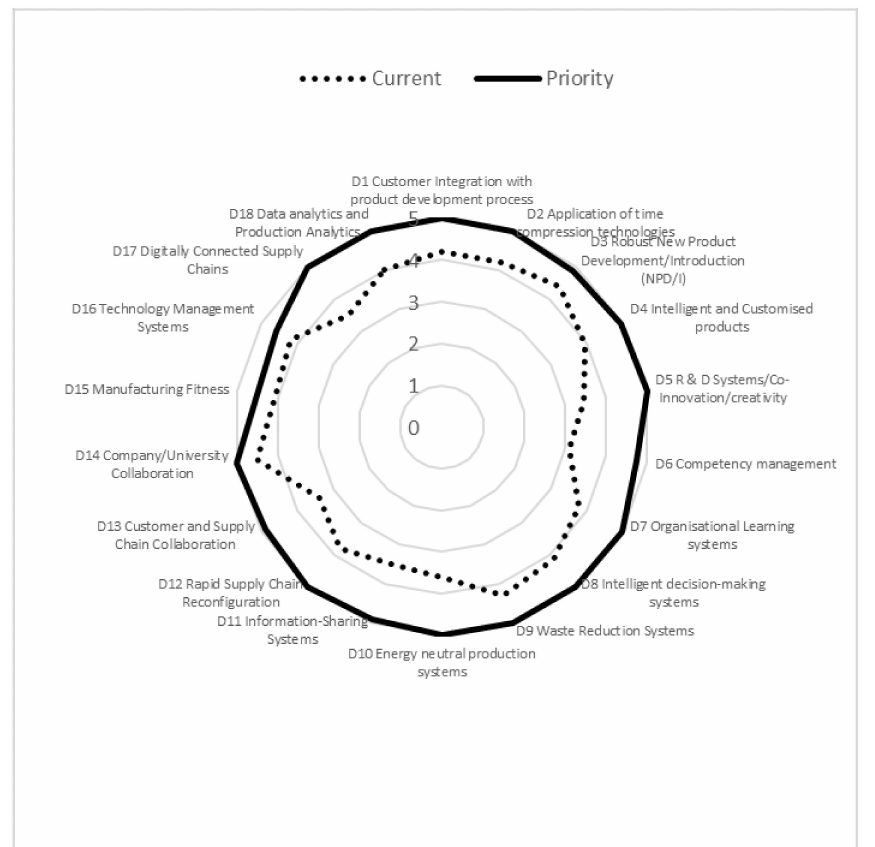
Figure 8. The analysis of current and future profiles of SMEs with 51–250